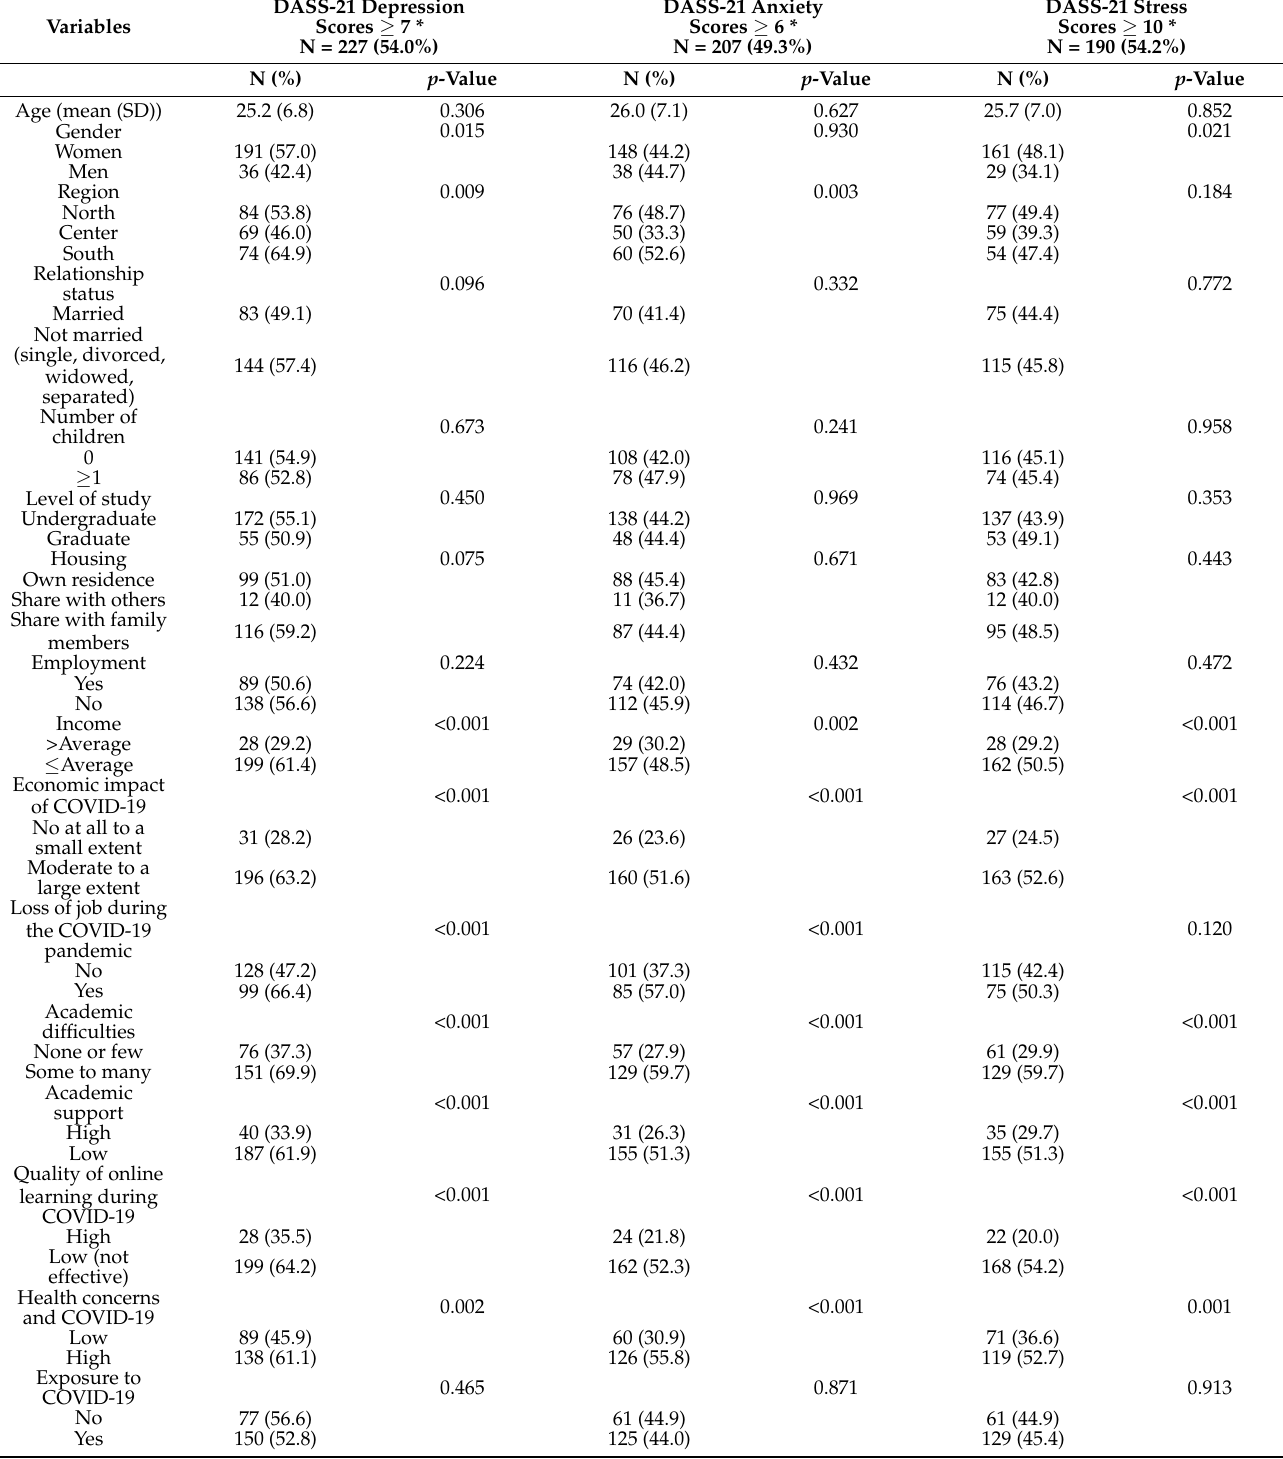
Table 2. Bivariate associations of demographic, health, and academic factors with mental health among higher-education students during COVID-19 pandemic ( n =